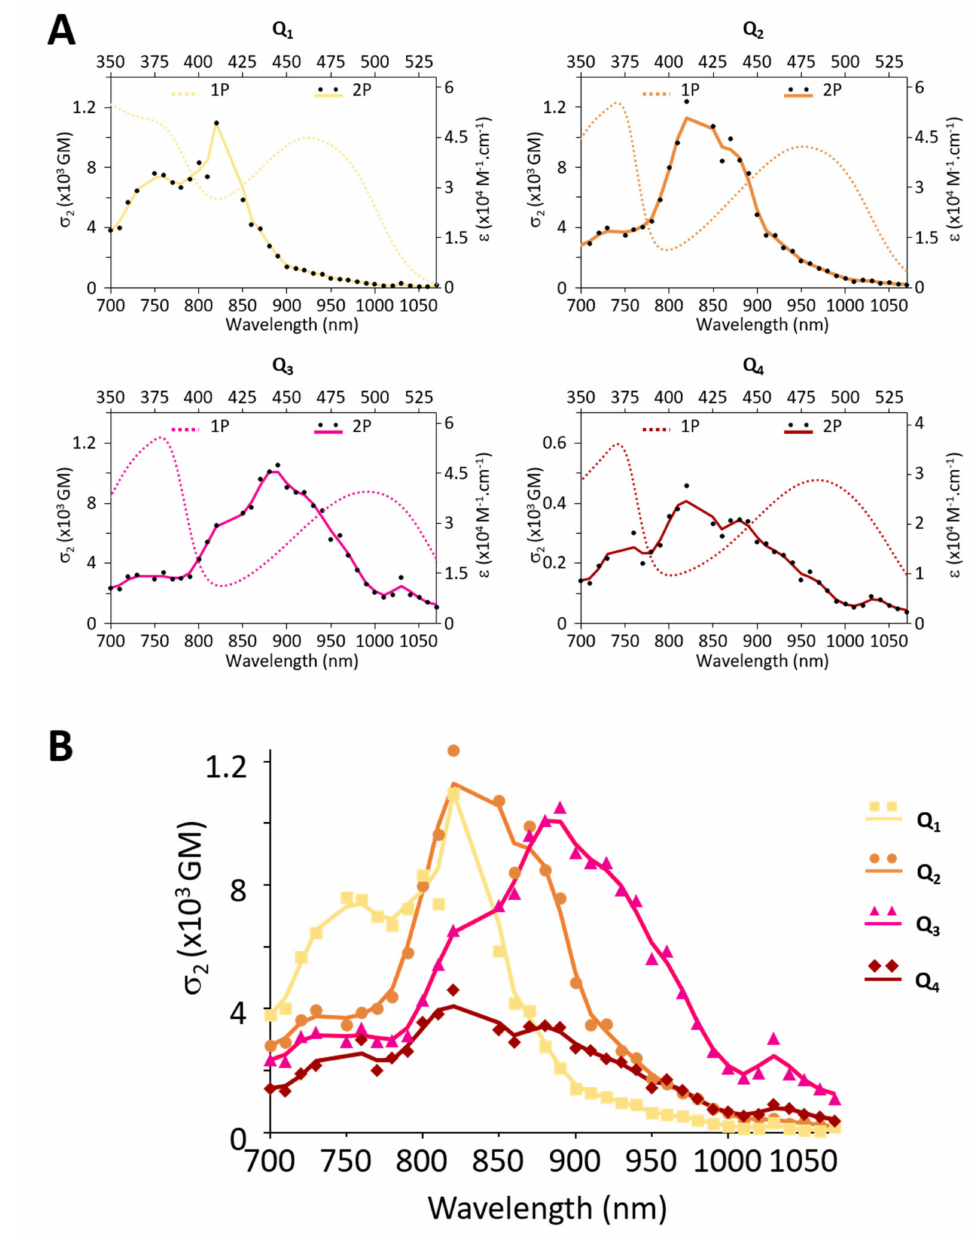
Figure 4. ( A ) Overlapped 1PA and 2PA spectra of each dye in toluene. ( B) Comparative 2PA spectra of Q 1 – Q 4 dyes in